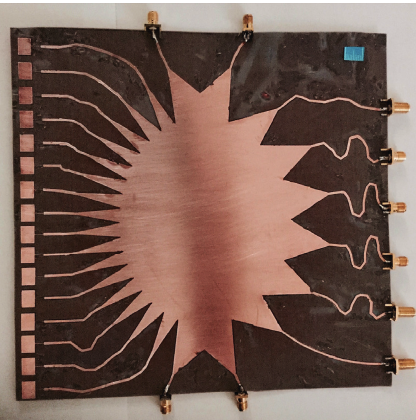
Figure 24: Photo of the Rotman lens prototype equipped with SMA coaxial connectors.